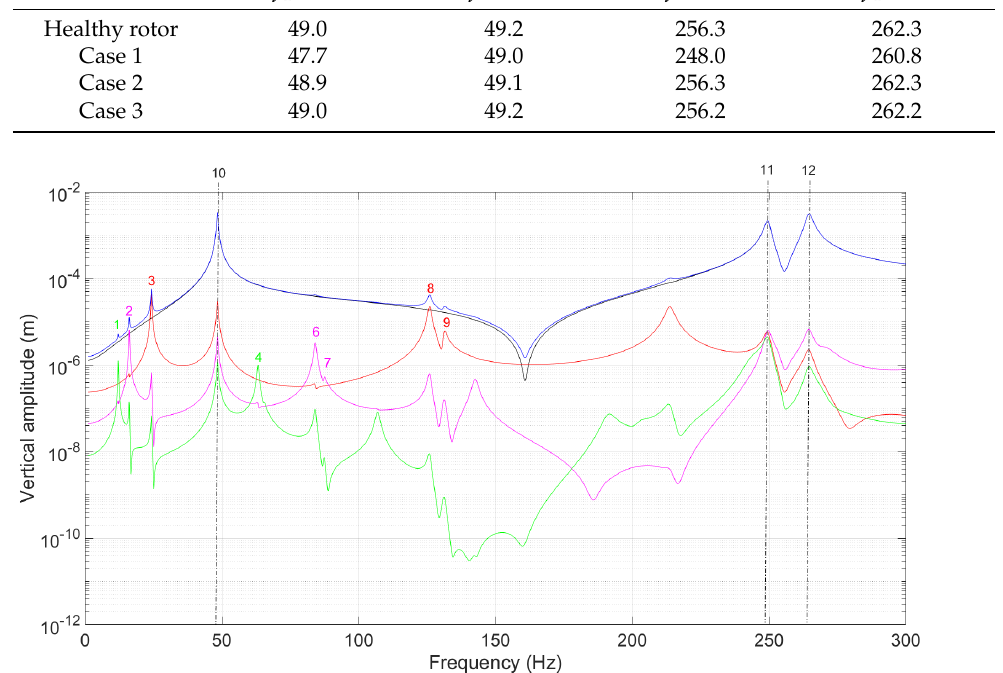
Figure 2. Vertical amplitudes at 0.1 m from the left side of the rotor system with a breathing crack (case 1— µ = 1 and L crack = 0.3625 m from the left side) (blue = nonlinear response, black = order 1, red = order 2, magenta = order 3, green = order 4).